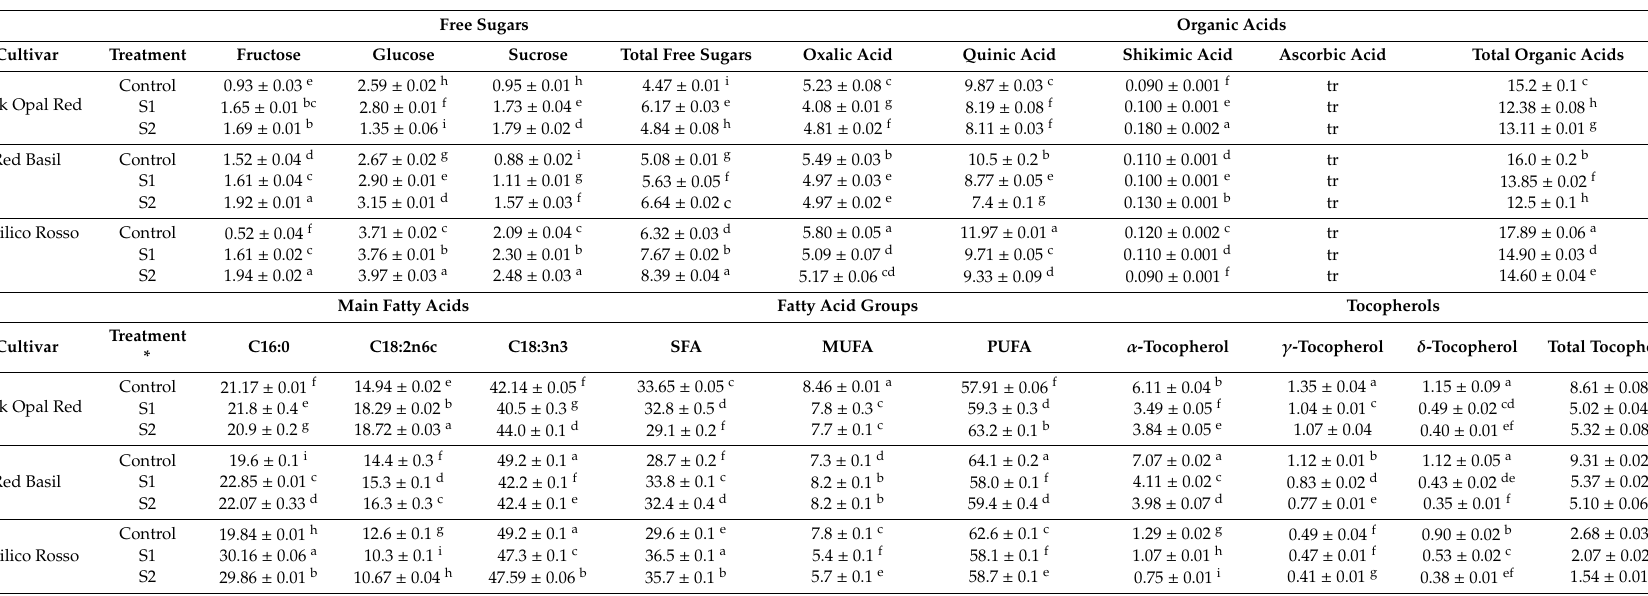
Table 2. Free sugars (g / 100 g dw), organic acids (g / 100 g dw), main fatty acids (%), fatty acid groups (%), and composition in tocopherols (mg / 100 g dw) identified in the tested basil cultivars in relation to salinity level (mean ± SD, n =